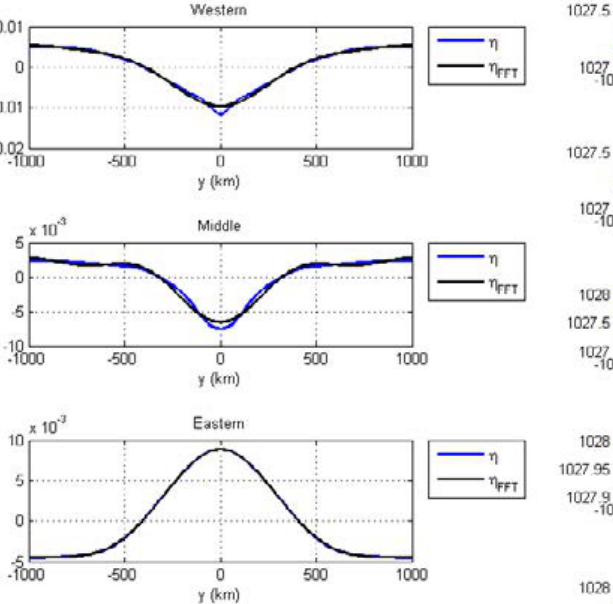
Fig. 7 : Sea level plot from the FFT results which occurred in 2015/2016, was triggered by